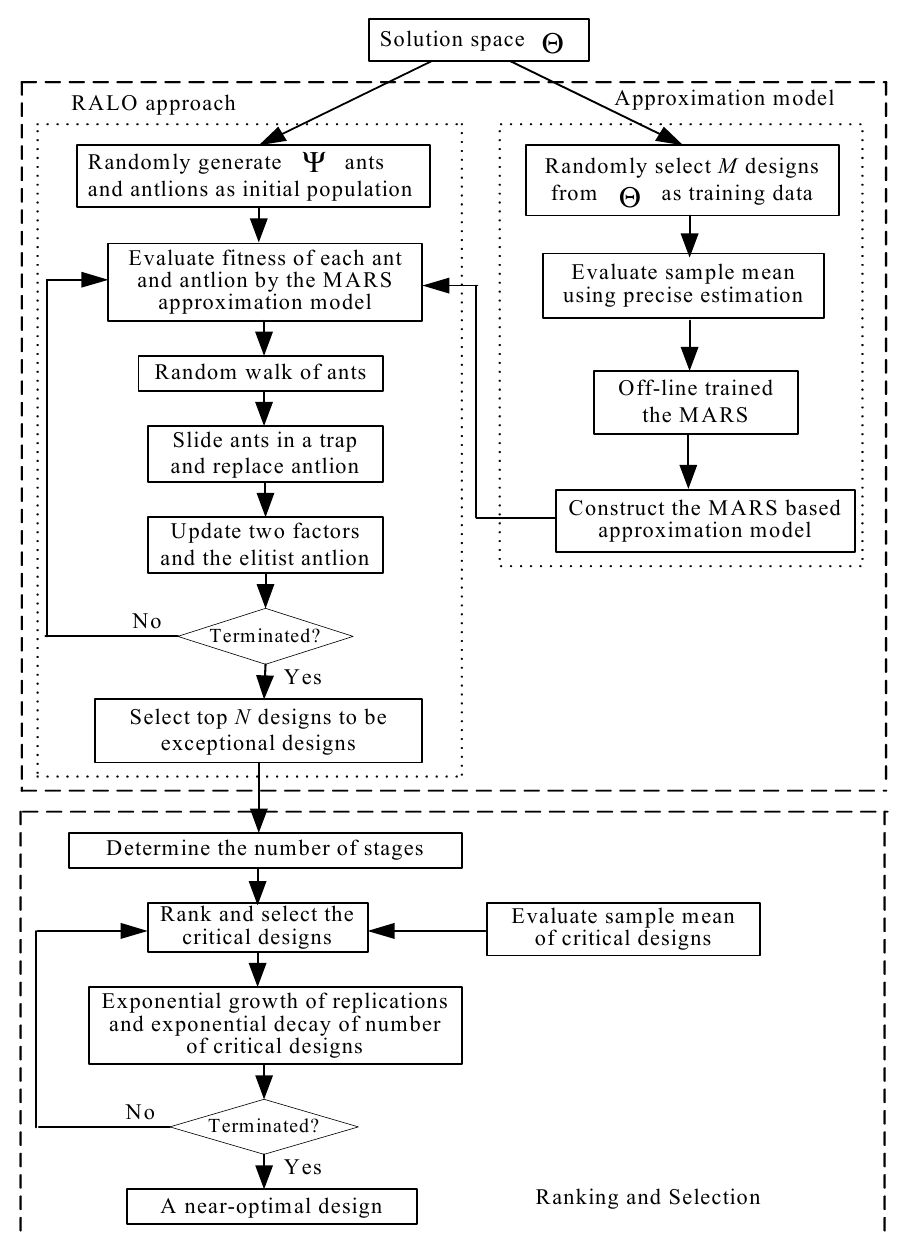
Figure 2. Flow diagram of the proposed OALO algorithm.